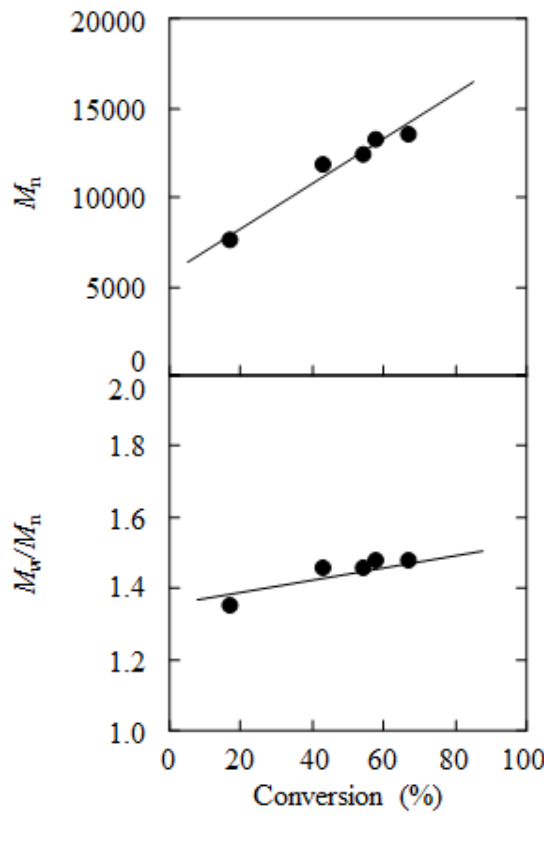
Figure 4. The plots of the molecular weight and its distribution vs. the conversion for the MTEMPO-mediated photopolymerization of GMA. MTEMPO/ r -AMDV = 1.06, t BuS/MTEMPO = 0.53. Where t BuS was (4- tert -butylphenyl)diphenylsulfonium triflate, r -AMDV was